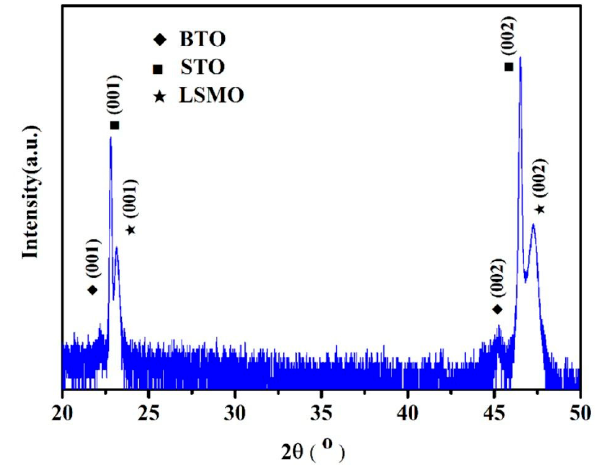
Figure 1. θ –2 θ patterns of BTO/LSMO films grown on (001) SrTiO 3 at room temperature.